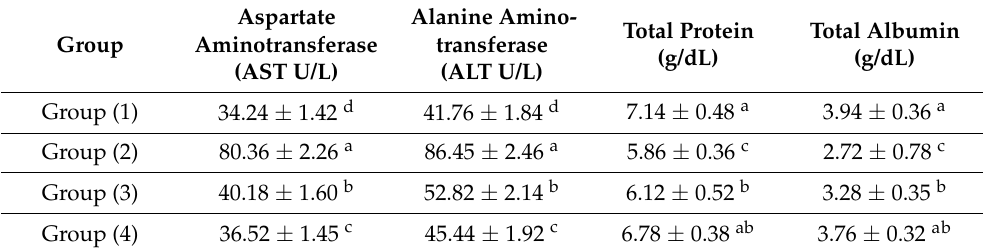
Table 6. Effect of fermented camel milk supplemented with SFP on liver function parameters in diabetic rats.